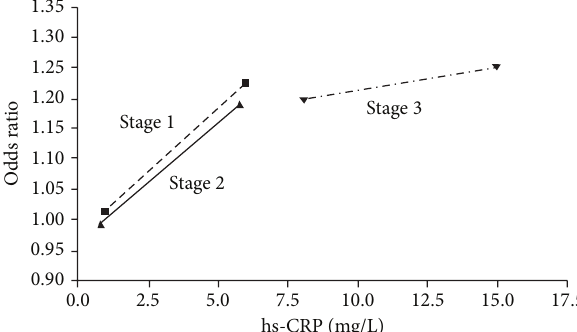
Figure 2: Multivariate-adjusted odds ratios for high-sensitivity C- reactive protein (hs-CRP) in different CKD stages. Hs-CRP was expressed in different CKD stages with value ranges from mean ± standard